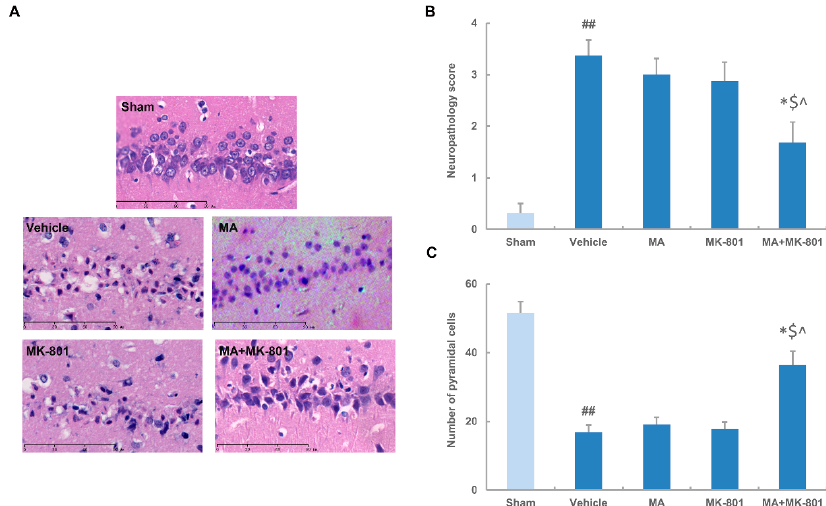
Figure 3. MK-801 combined with maslinic acid improves ischemic outcome in rats. ( A ) Hippocampal neuronal damage in CA1 subregion by H&E staining. Rats were subjected to 2 h of ischemia followed by 70 h of reperfusion. Maslinic acid (0.4 μ g/mL) was administered 15 min before MCAO. MK-801 (0.5 mg/kg) was given at 3 h after MCAO; ( B ) Analysis of neuronal damage by neuropathalogical score; ( C ) Number of pyramidal neurons was counted in CA1 subregion. Data were expressed as means ± SEM from three independent animals containing three randomly selected fields. ## p < 0.01 versus the sham group; * p < 0.05 versus the vehicle group; $ p < 0.05 versus maslinic acid-treated group; ^ p < 0.05 versus MK-801-treated group. Scale bar: 90 μ m.